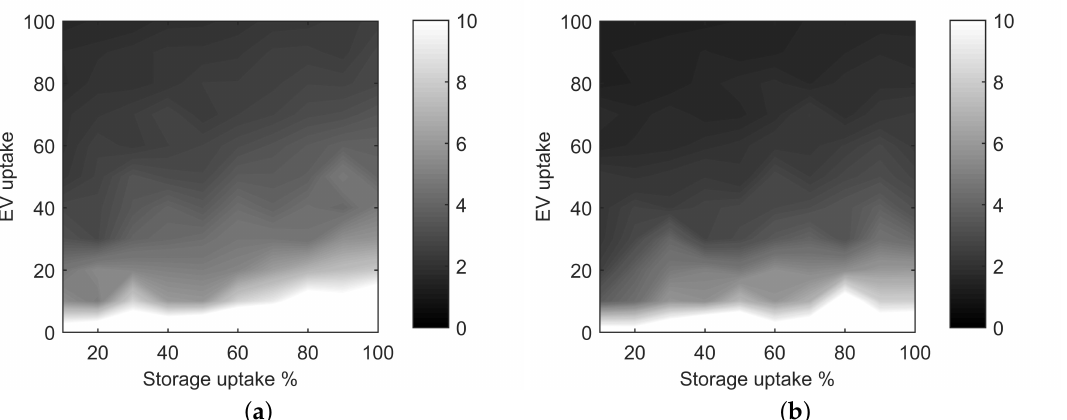
Figure 15. Peak-to-Average Ratios (PAR) of the battery cycling profiles of each load’s battery storage device over four days for ( a ) AIMD and ( b ) AIMD+. ( a ) Cycling PAR for AIMD; ( b ) cycling PAR for AIMD+.